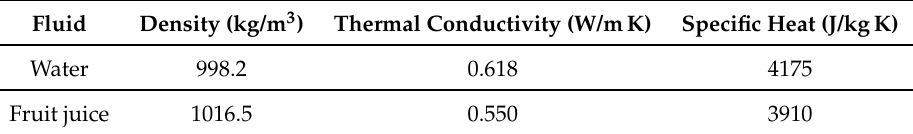
Table 1. Water and fruit juice properties at the